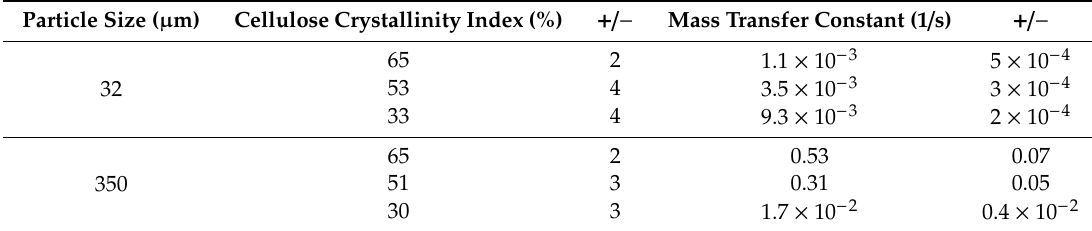
Table 2. The mass transfer constant of resveratrol as a function of particle size and crystallinity index of cell wall